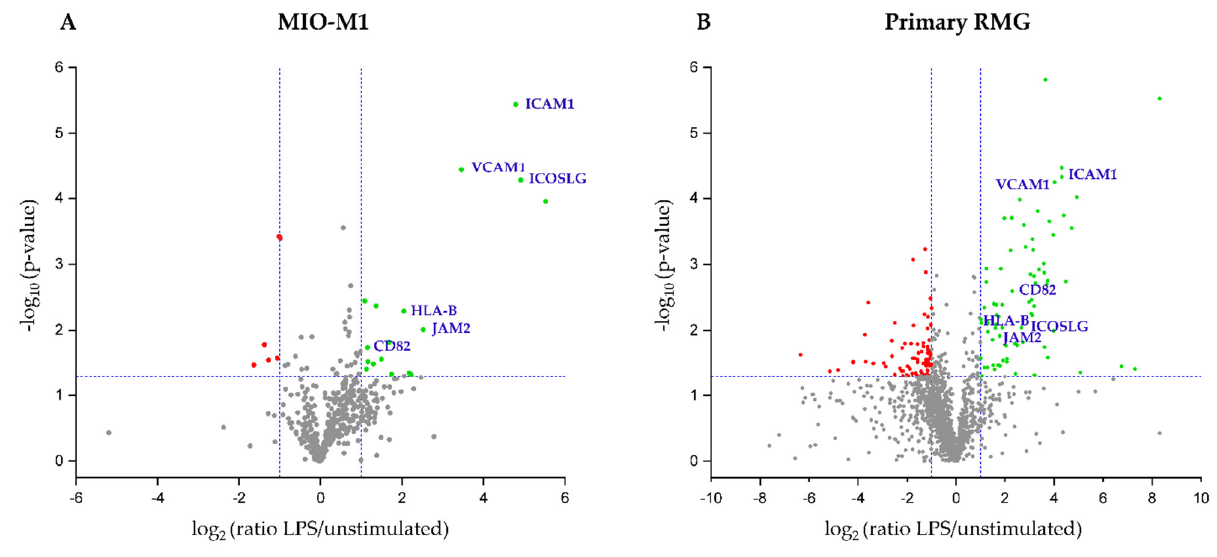
Cells 2021 , 10 , x FOR PEER REVIEW